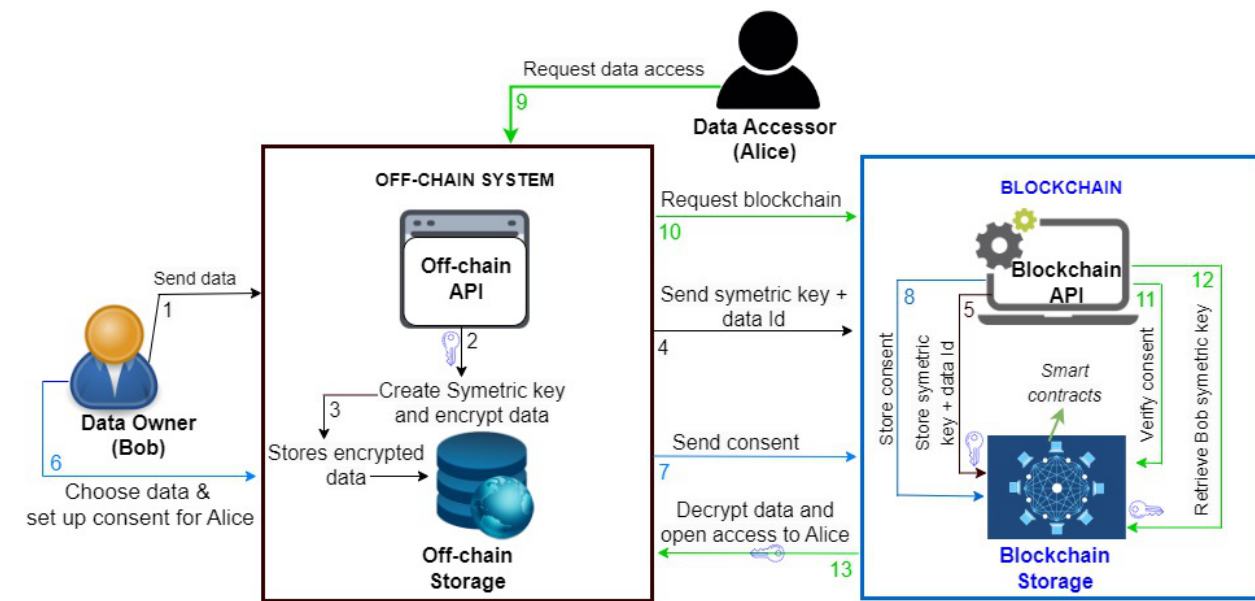
Figure 3. Generic architecture of the data control system based on data